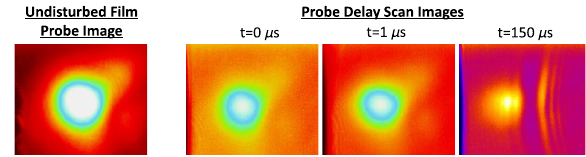
FIG. 2. These are representative probe images of 40 nm films at three different delay values: 0, 1, and 150 μ s. An image of an undisturbed film is also displayed for comparison.